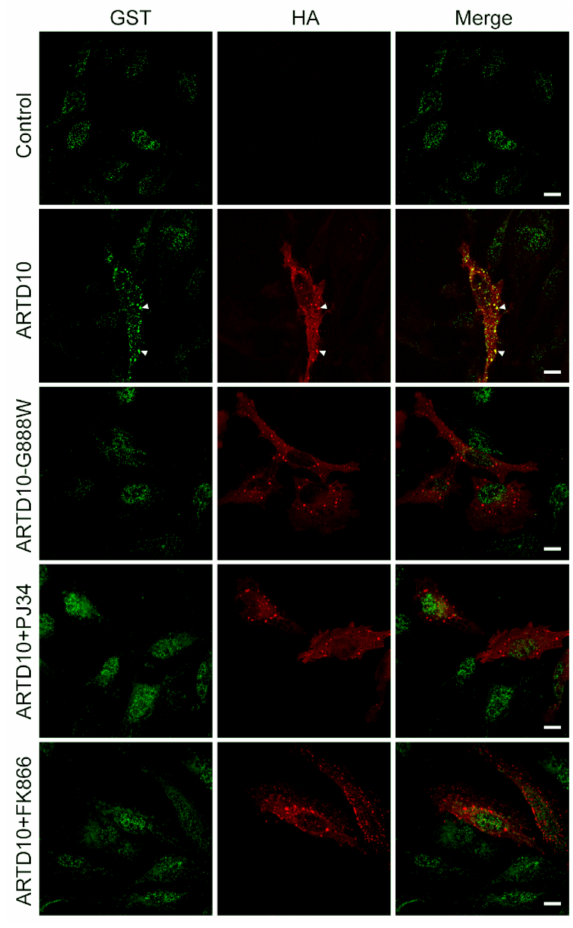
Figure 3. ARTD10/PARP10-cytoplasmic cell bodies are specifically recognised by the Af1521 wt macro domain. Representative immunofluorescence microscopy of HeLa cells that were mock-transfected (Control) or were transiently transfected with ARTD10, ARTD10-G888W, or ARTD10 with treatment with PJ34 (ARTD10 + PJ34) or with FK866 (ARTD10 + FK866). The cells were incubated with GST- m Af1521 wt, stained with anti-Glutathione S-Transferase (GST) (GST; green) and anti-HA (HA; red) antibodies, and analysed by immunofluorescence microscopy. Scale bars, 10 µ m. Data are representative of at least three independent